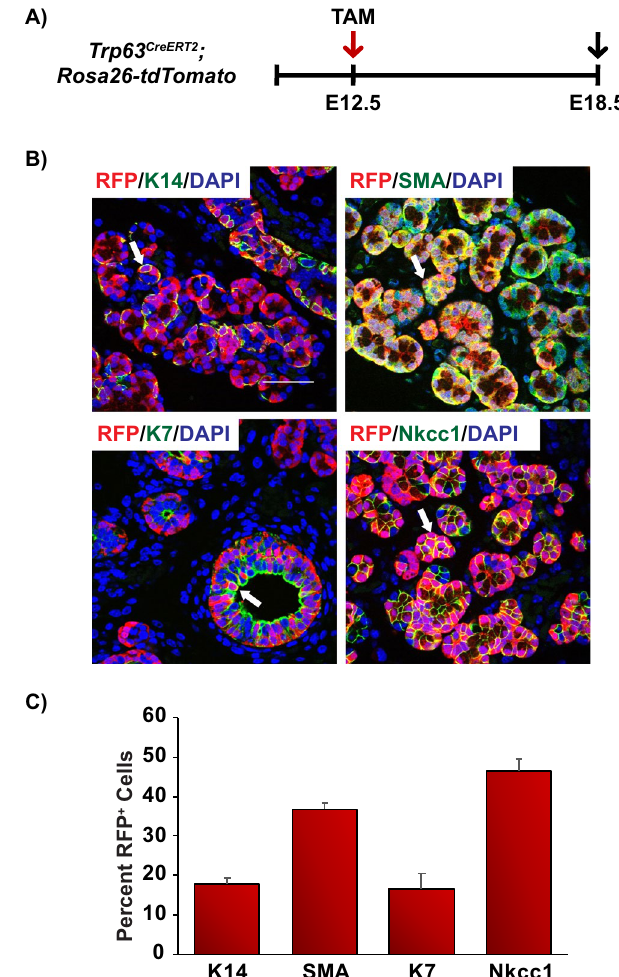
Figure 4. Contribution of p63 + cells during salivary gland morphogenesis. ( A ) Schematic of the experimental timeline used for the embryonic genetic lineage tracing experiments in the Trp63 CreERT2 ;Rosa26-tdTomato mice. RFP expression was induced at E12.5 by injection of TAM to pregnant females and cells were traced for 6 days and glands were dissected at E18.5. ( B ) p63 + cells contribute to all epithelial cell lineages during submandibular gland morphogenesis. ( C ) Quantification of the percentage of RFP + cells which co-express the various cell lineage markers as indicated. Data are represented as the mean ± standard deviation (S.D.). Arrows highlight double positive cells as indicated. Scale bar 37 μ m. TAM- tamoxifen, E-embryonic. n = 4